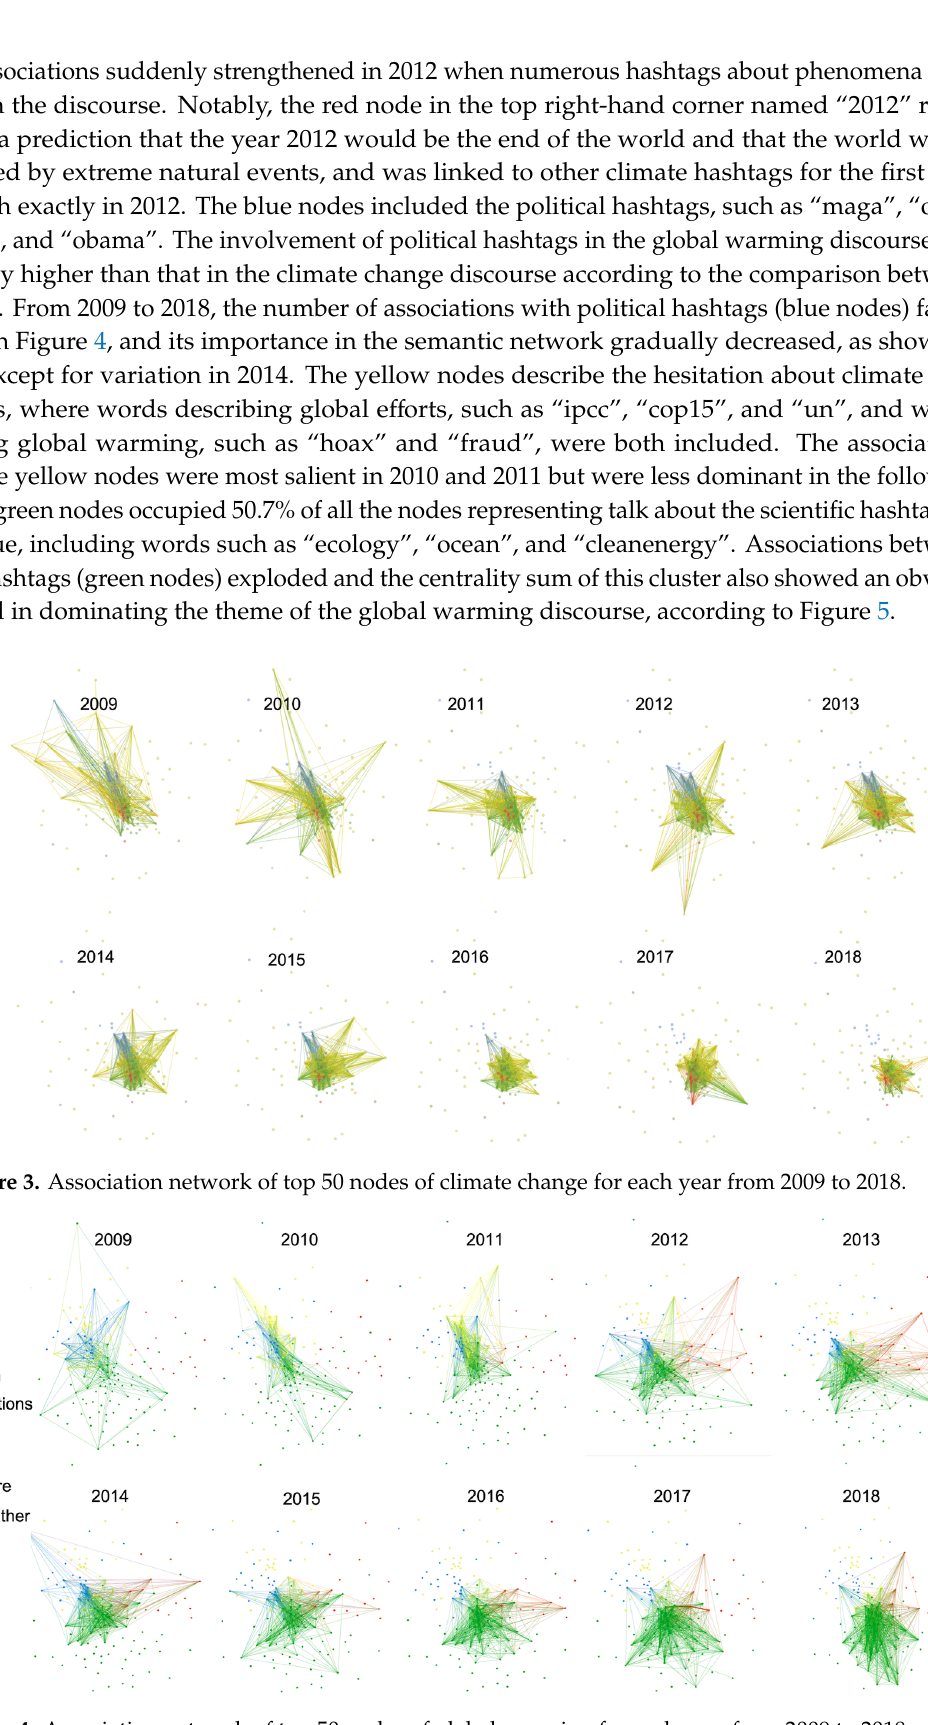
Figure 4. Association network of top 50 nodes of global warming for each year from 2009 to 2018.